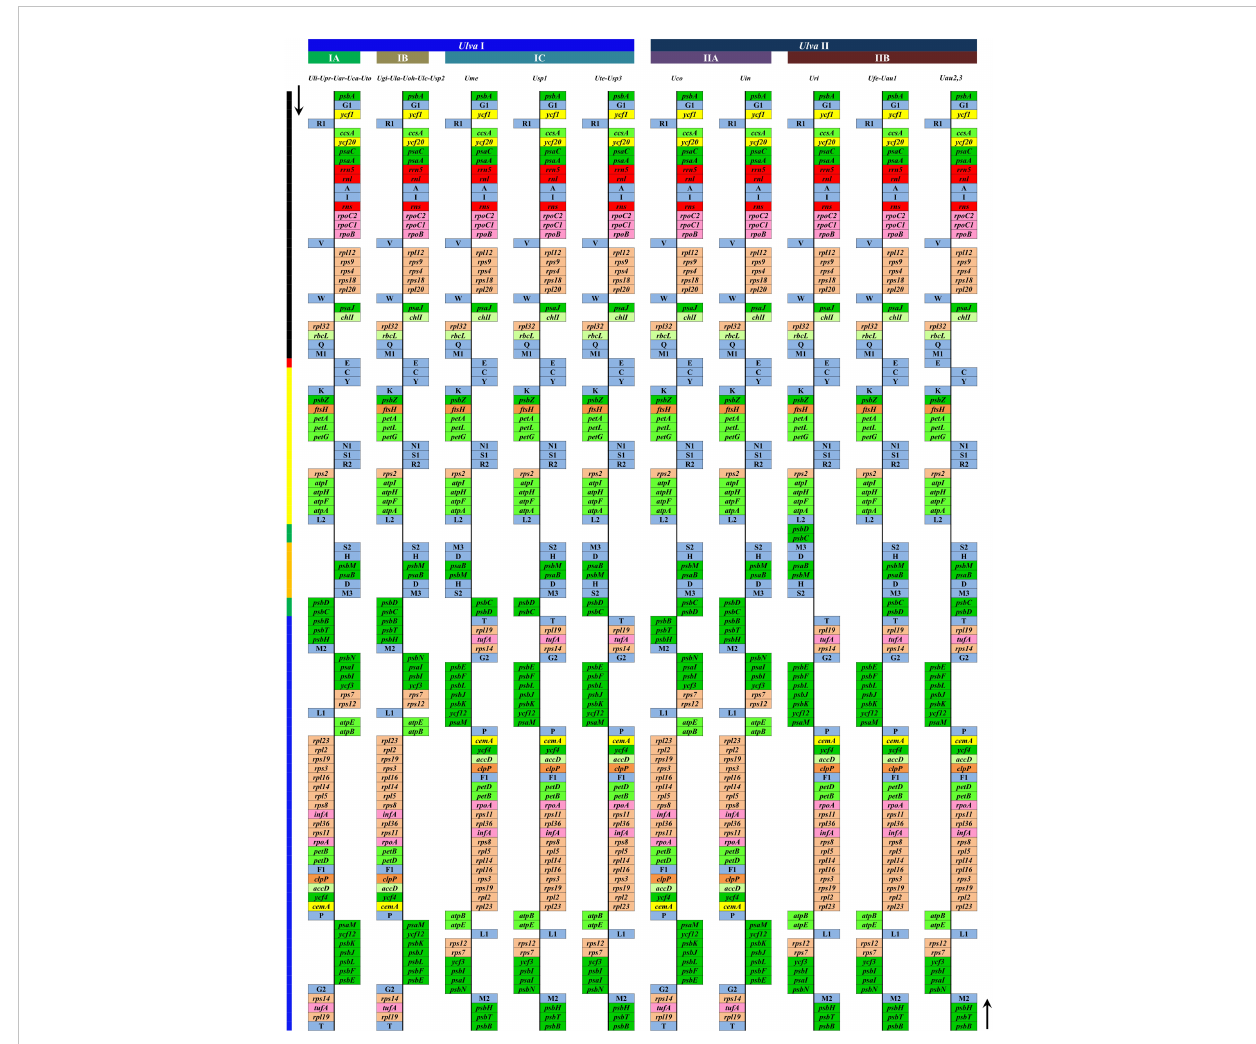
FIGURE 8 Comparison of plastome organization and gene order between Ulva lineage I and II. Thick lines with different colors on the left represented different gene blocks. Thick lines with different colors on the top represented different Ulva lineages. The arrows indicated the direction of gene transcription. Only canonical genes were shown as fi lled boxes in different colors representing different gene